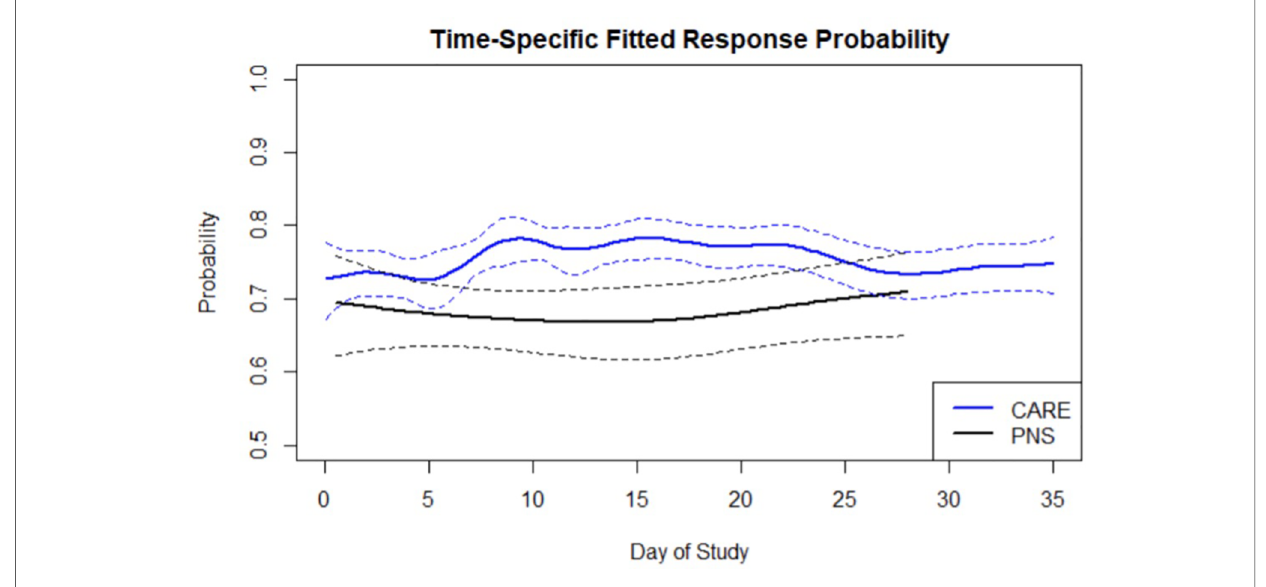
FIGURE 2 Time-varying response rate across days in the study in the CARE and PNS